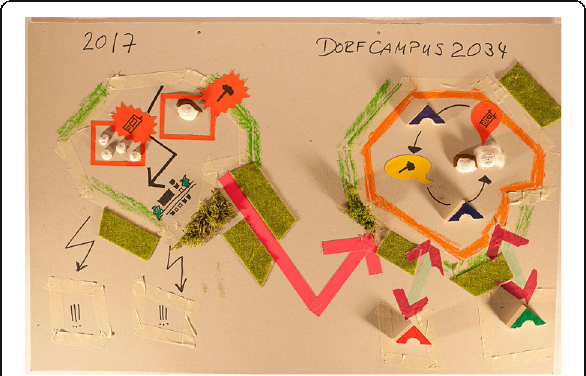
Fig. 2 “ Rural campus 2034 ”— selected image of future visions of rural areas developed by participants © Fraunhofer